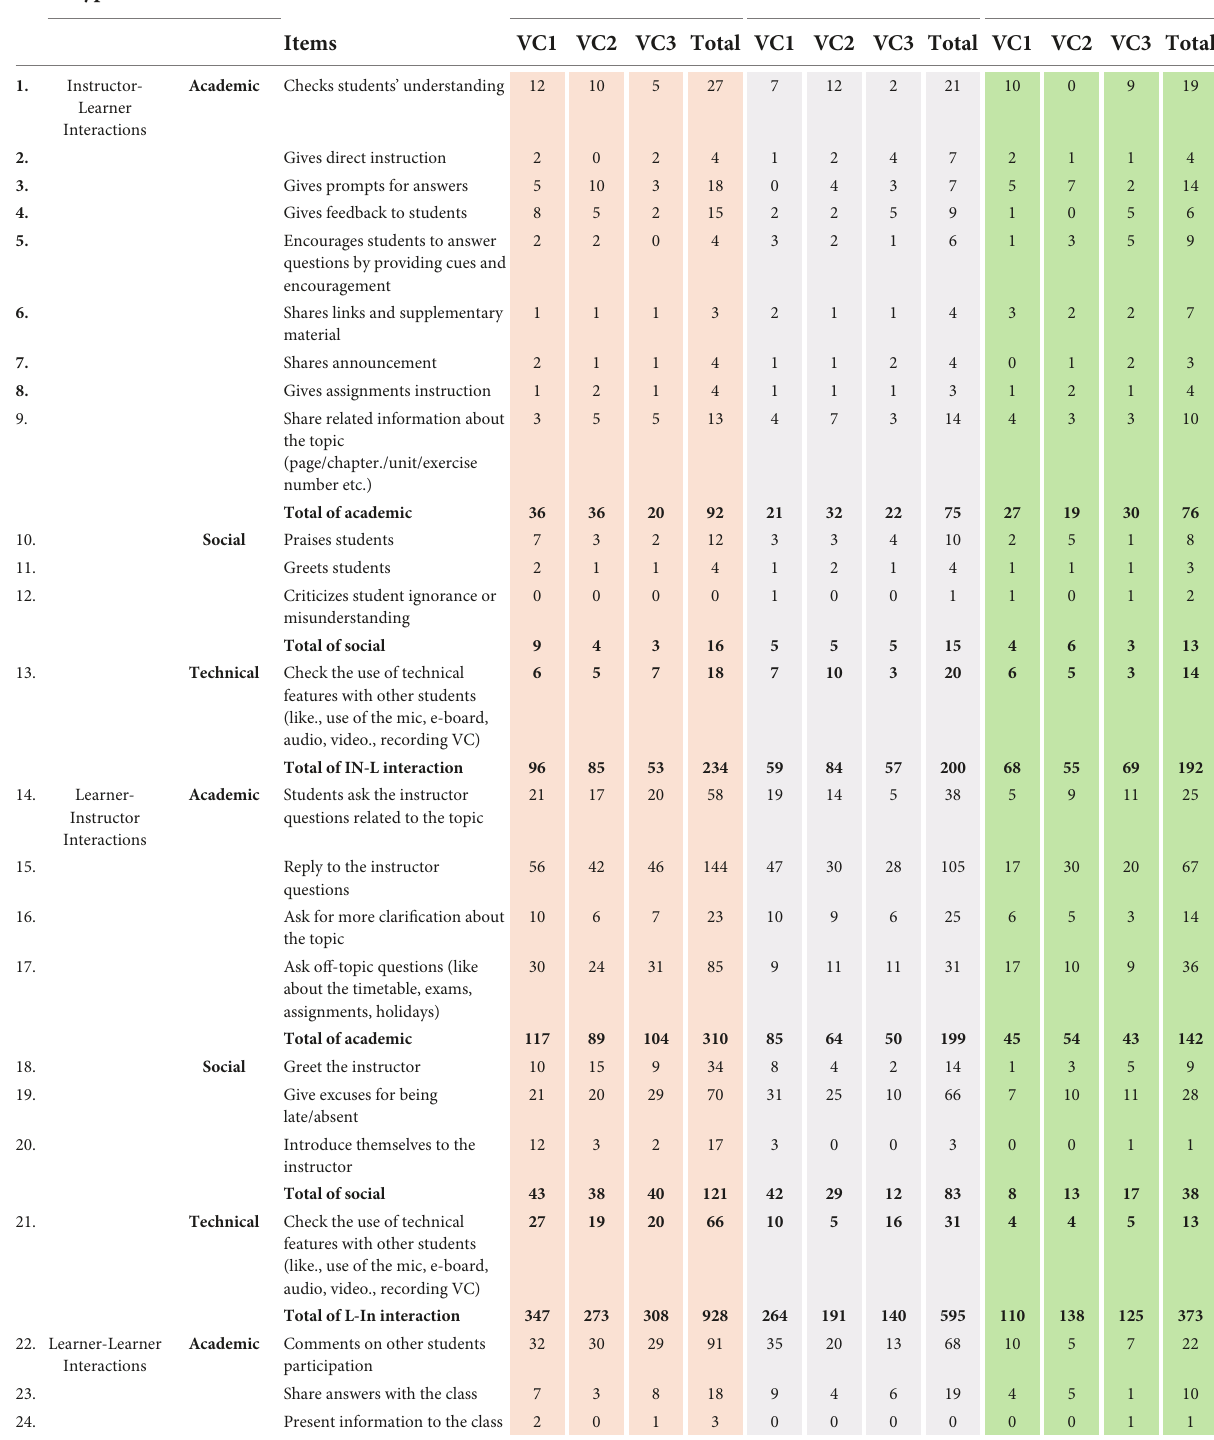
TABLE 2 Archival analysis of text-based interactions in virtual class (VC). Types of Interaction